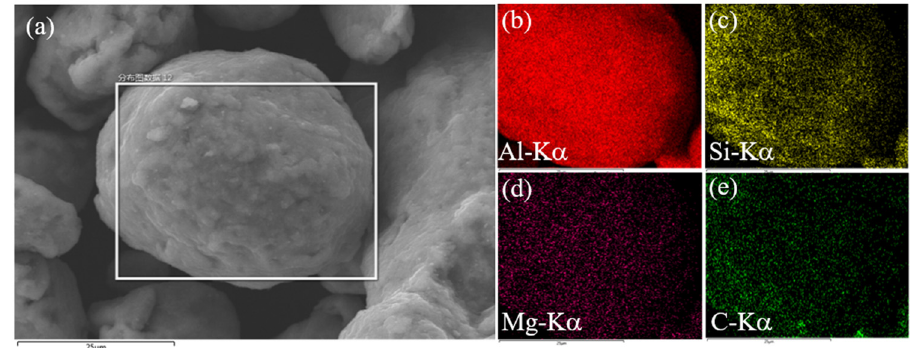
Figure 5: ( a ) SEM image of the ball - milled CNTs/AlSi10Mg nanocomposite powders with 0.5 wt% CNTs. EDS mapping showing the elemental distribution and concentration of ( b ) Al, ( c ) Si, ( d ) Mg and ( e ) C on the particle